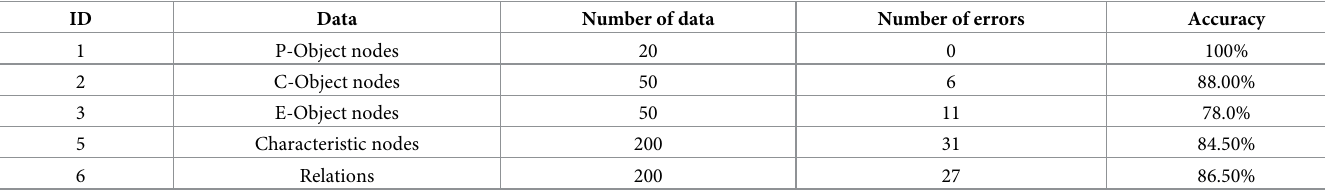
Table 6. Accuracy of node and relationship extraction (random